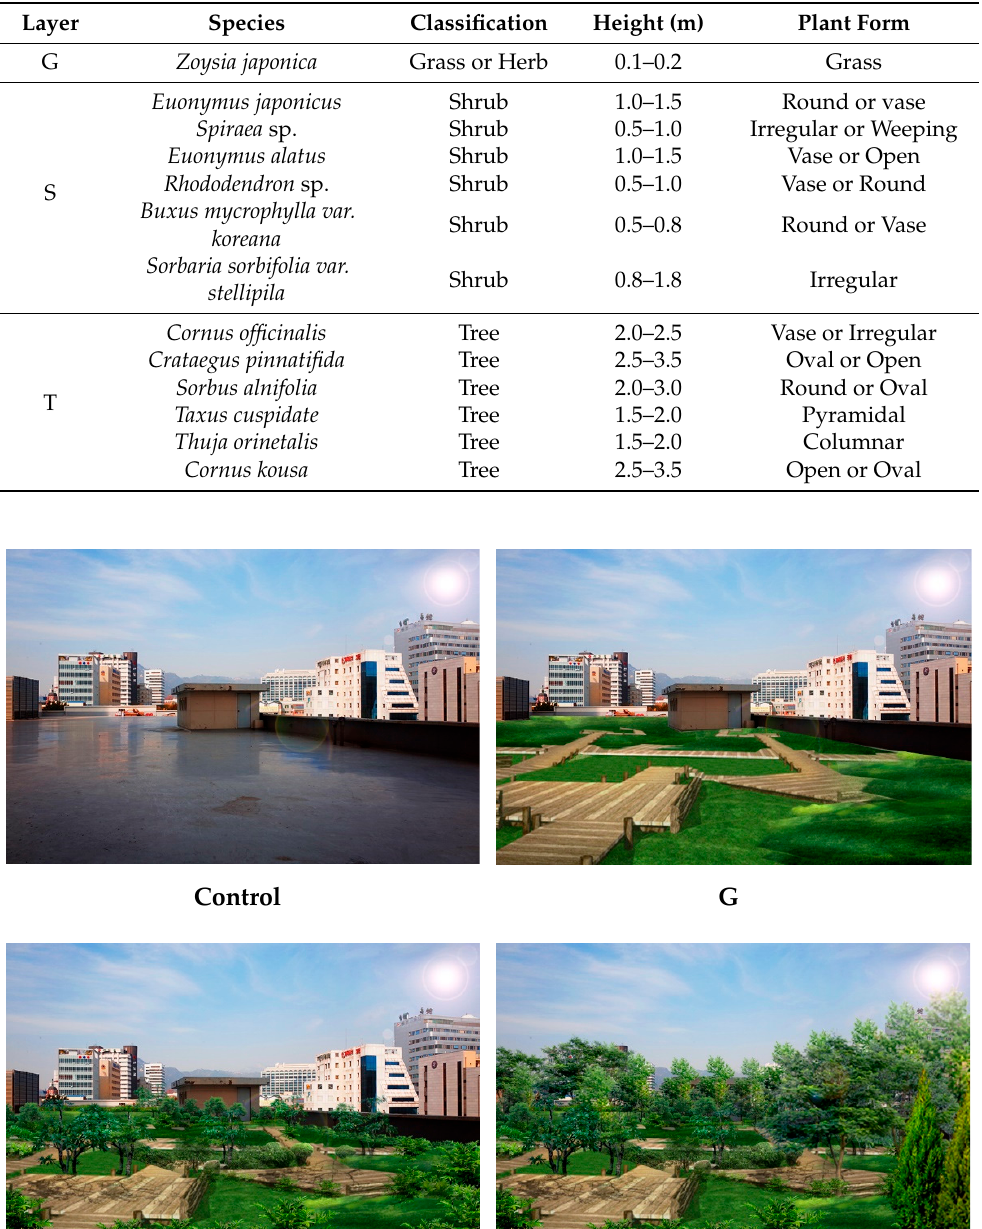
Table 1. Planted species in three vegetation layers; G: grass layer; S: shrub layer; T: tree layer.